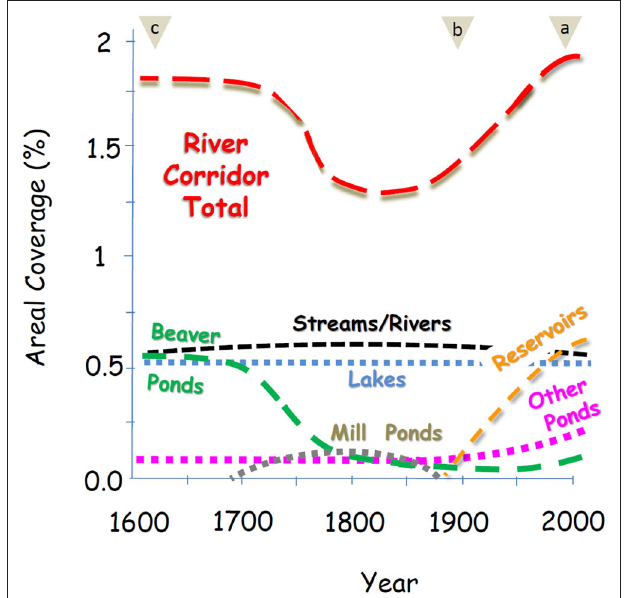
FIGURE 1 | Four hundred years of river corridor change summarized as trends in surface areal coverage of lotic and lentic waterbodies. Key estimation periods are indicated by tan triangles showing present-day time period (circa 2000) analysis of high-resolution National Hydrography Dataset (NHD) and National Inventory of Dams (NID) data sources for streams and rivers, lakes, reservoirs, and small ponds (a), early twentieth century time period (circa 1900) estimates based on subtracting reservoirs and managed small ponds from present-day values (b), and pre-Colonial time period (circa 1600) estimates based on published estimates of the CONUS beaver population and pond area prior to the near extermination of beavers during the 1700s and 1800s (c) (see Supplementary Material ). Trends between those periods are inferred based on less certain information from published accounts cited in Changing Balance of Lotic and Lentic Contributions section of the